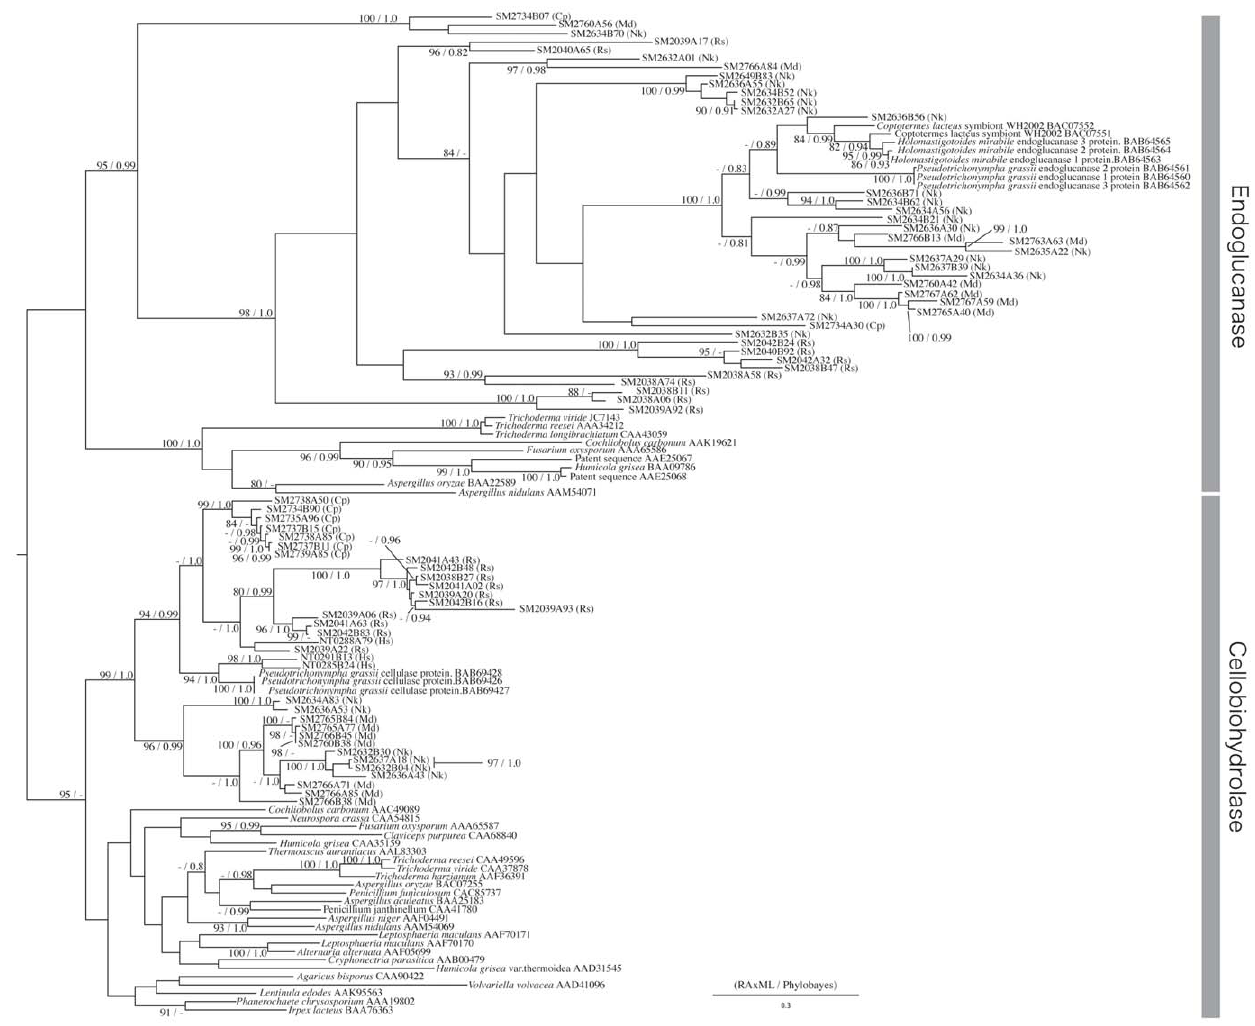
Figure 4. Phylogenetic tree of GHF7. Numbered clones (for example SM2734B07) are cellulase genes identified in this study from the symbiotic protists of termites. Letters in parentheses after each clone denote host termite species (Rs = Reticulitermes speratus , Nk = Neotermes koshunensis , Hs = Hodotermopsis sjostedti , Md = Mastotermes darwiniensis , Cp = Cryptocercus punctulatus ). Accession numbers of reference sequences are denoted after species names.